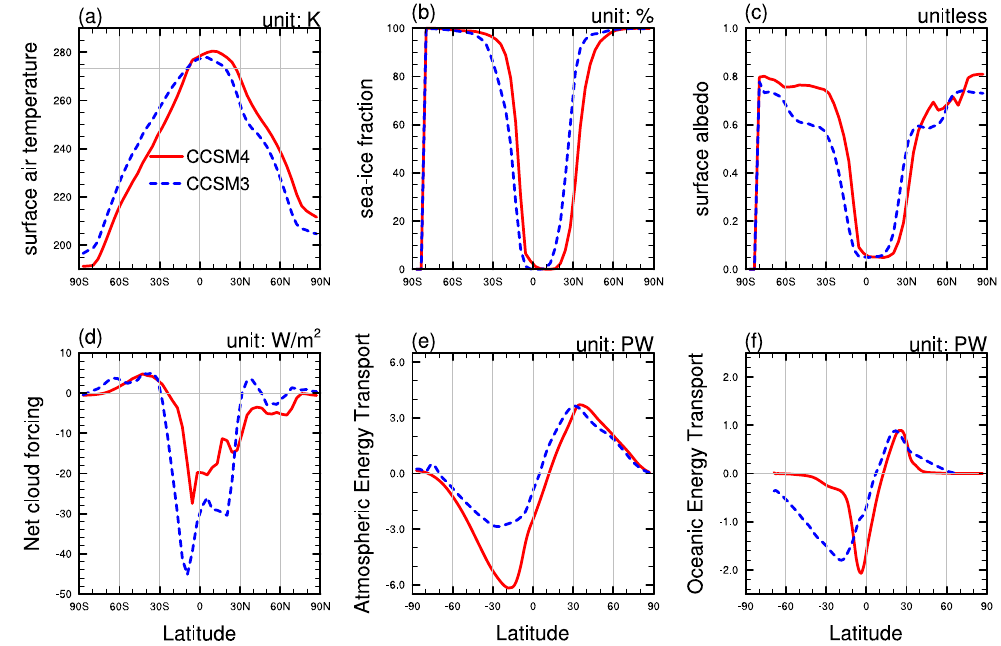
Fig. 9. CCSM4 (solid line) vs. CCSM3 (dashed line). Same as Fig. 1, but for the case of 94% solar radiation with 100ppmv CO 2 in CCSM4 and for the case of 94% solar radiation with 50ppmv CO 2 in